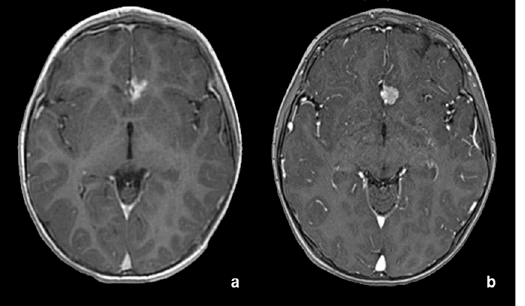
Figure 5. ( a ) Post-operative MRI at three months revealing minimal residual tumor and subsequent relapse at one-year follow-up ( b